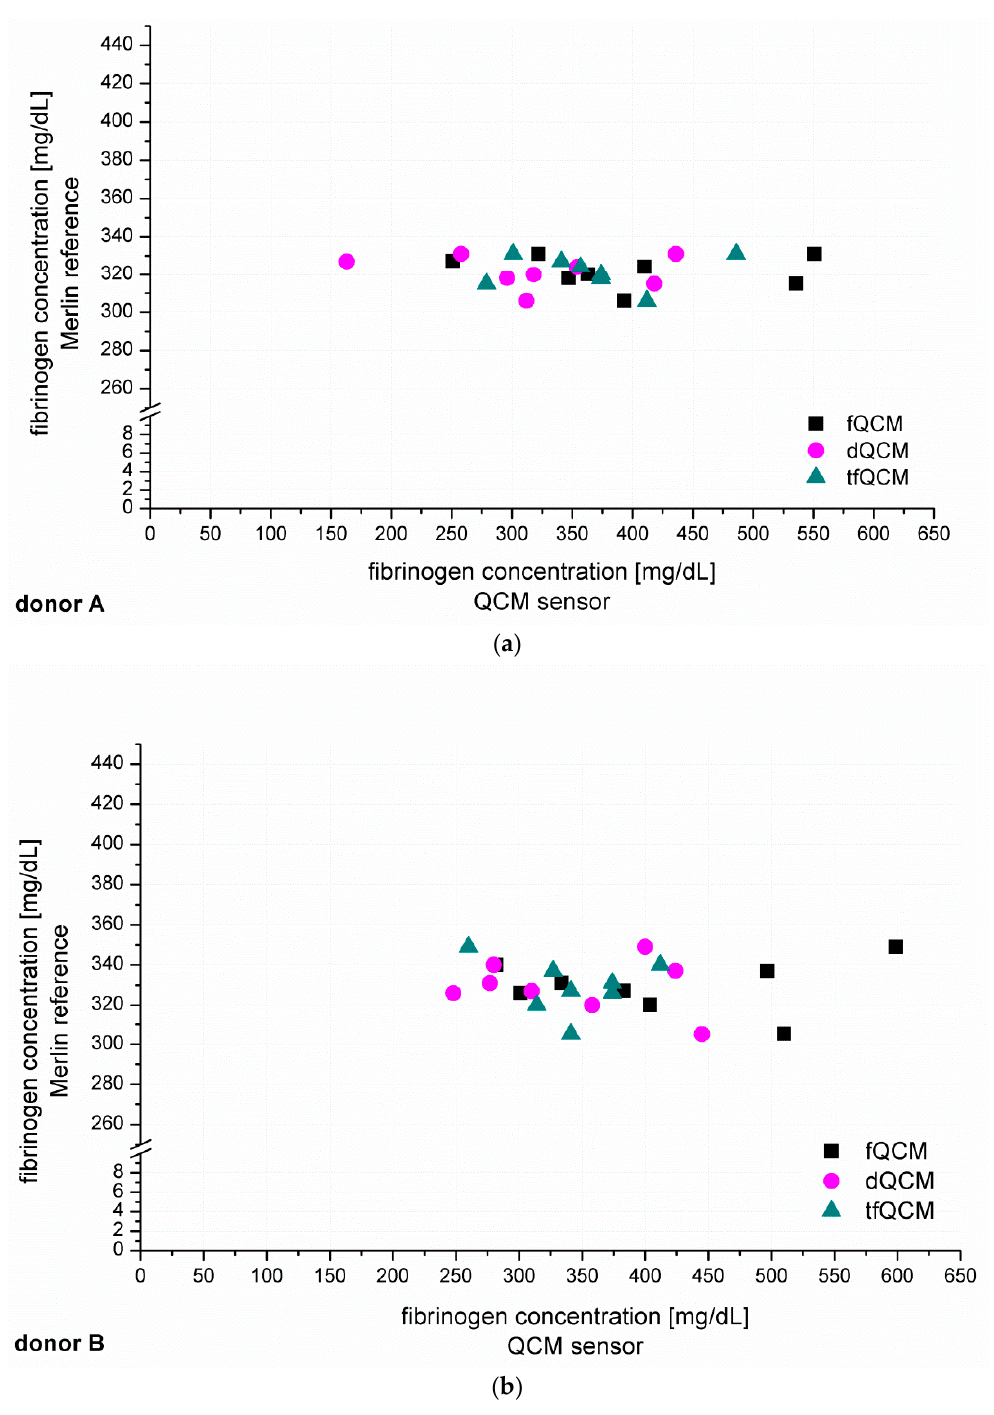
Figure 4. Cont . Figure 4.